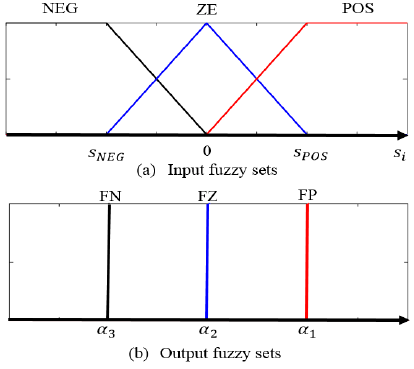
Figure 6. The input and output membership functions (MFs).